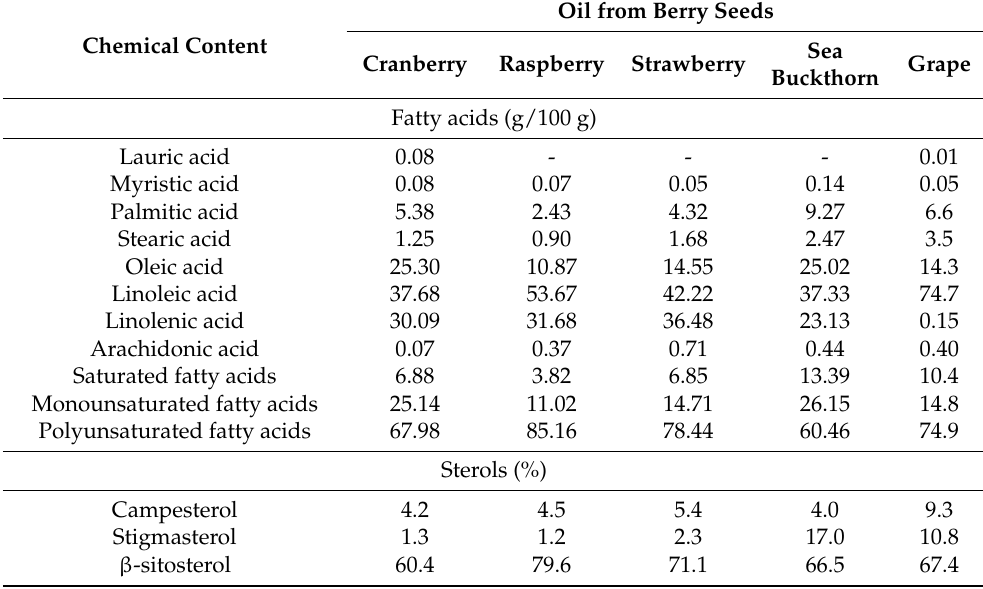
Table 2. The content of sterols and fatty acids in cold-pressed berry seed oils